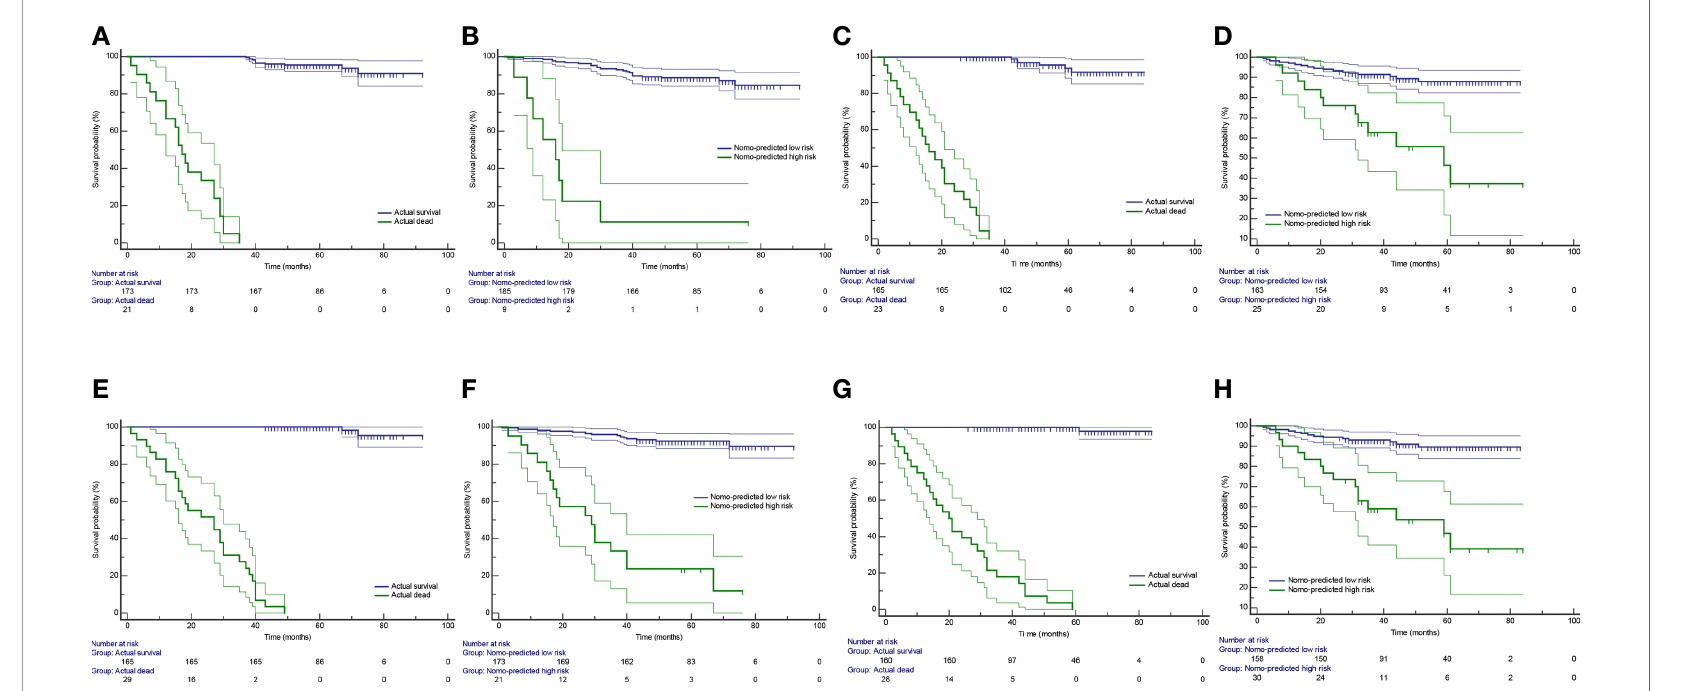
FIGURE 7 | Kaplan-Meier survival curves in group strati fi cation. Based on survival probability predicted by the radiomics nomogram, patients were strati fi ed into the Nomo-predicted high-risk group (survival probability < 0.5) and the Nomo-predicted low-risk group (survival probability > 0.5). The Kaplan-Meier survival curves were depicted by using the actual survival status (A) and the Nomo-predicted risk group (B) at 3 years as prediction factor in the training cohort. (C, D) are corresponding fi gures in the test cohort. The Kaplan-Meier survival curves were depicted by using the actual survival status (E) and the Nomo-predicted risk group (F) at 5 years as prediction factor in the training cohort. (G, H) are corresponding fi gures in the test cohort. Areas between thin lines of the same color represent 95% con fi dence